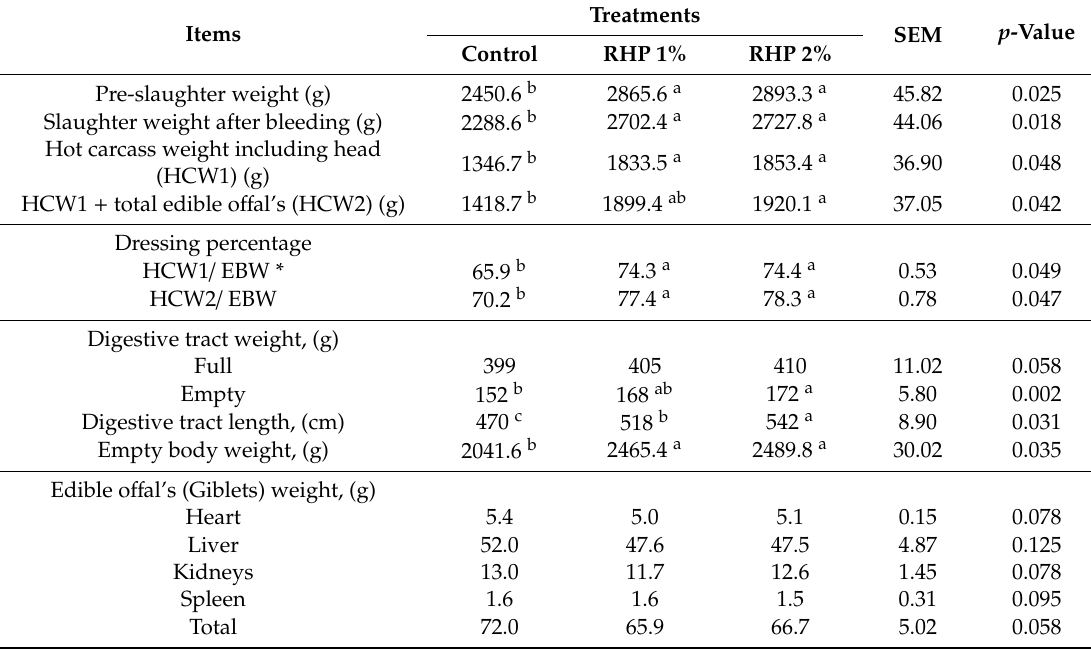
Table 3. Rabbits carcass characteristics, dressing percentage, and giblets of New Zealand white as a ff ected by dietary 0, 1, or 2 % red hot pepper for 8 weeks of treatment (n = 10 rabbits per